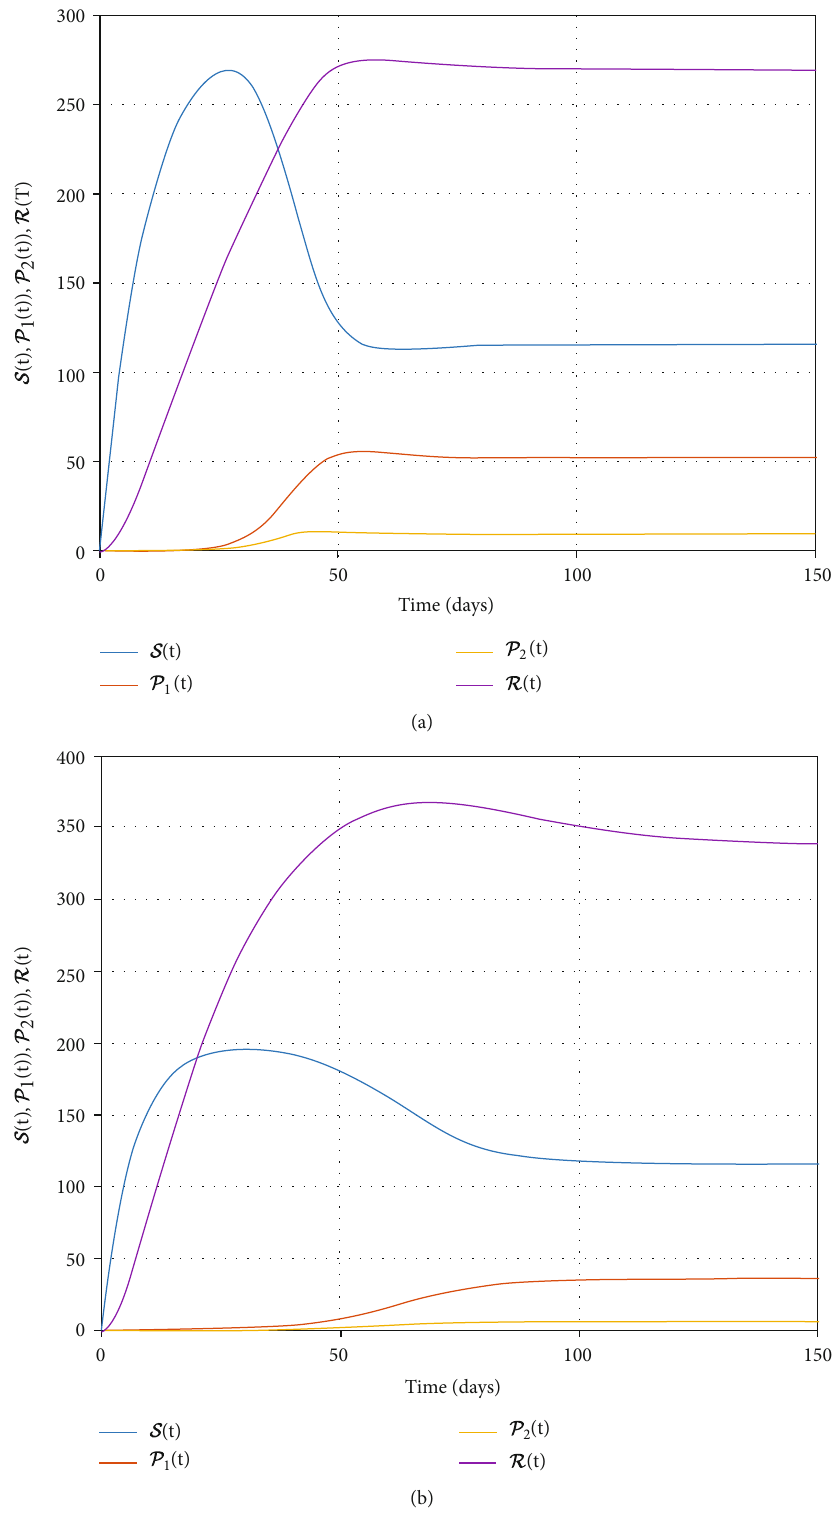
Figure 3: Behaviors of four trajectories for (a) vaccination rate b = 0 : 05 and (b) vaccination rate b = 0 : 1 , under fractal-fractional order ω = v = 1